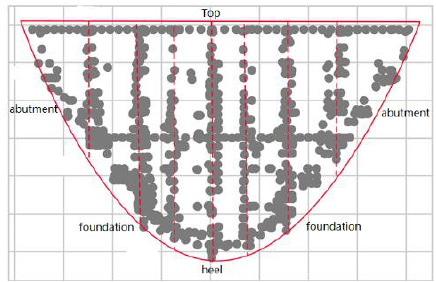
Figure 8. The spatial distribution of sensor nodes in the dam safety monitoring system.